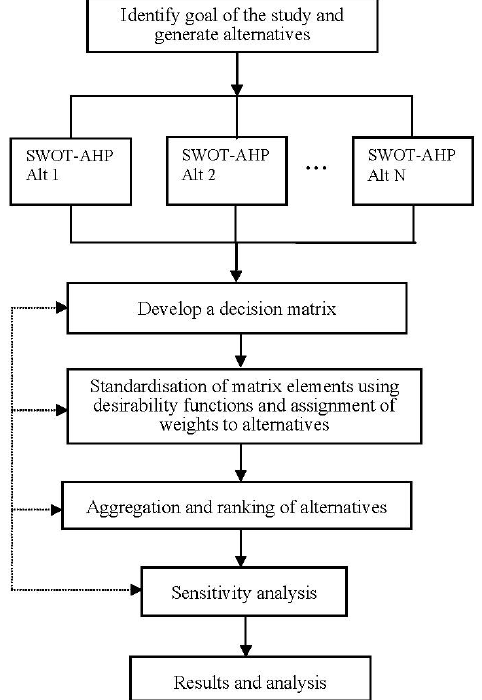
Figure 1. Flow chart of the proposed methodology. Note: doted lines show feedback between the stages). Alt 1, Alt 2, …, Alt N , represent the technologies under appraisal. SWOT-AHP: strengths, weaknesses, opportunities and threats-analytical hierarchy process.